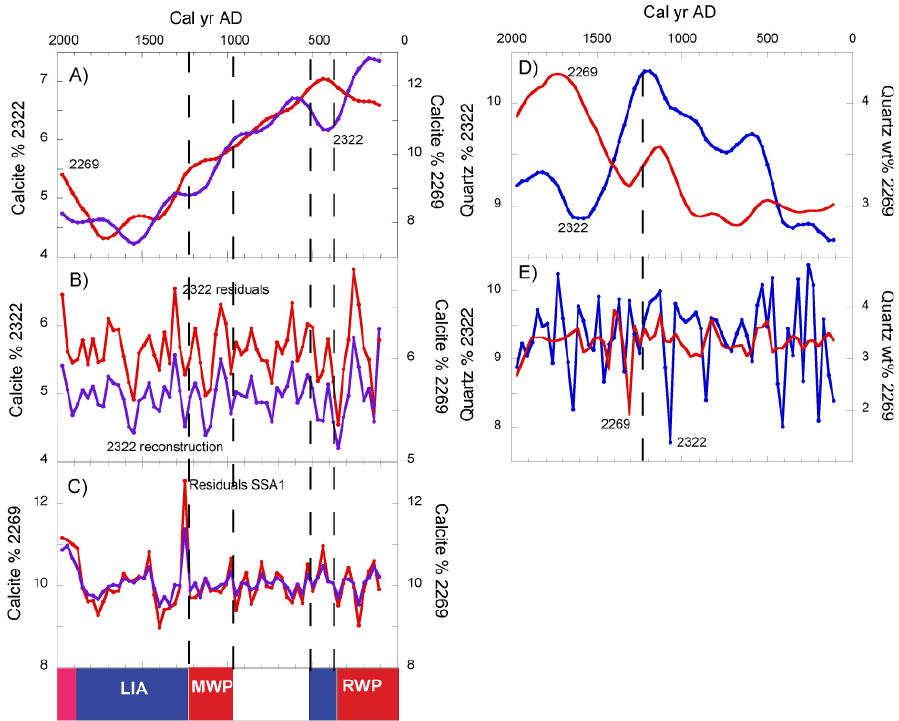
Fig. 11. (A) The SSA1 detrended calcite data for sites MD99-2322 and -2269 (Fig. 1), some 440km apart. (B) Residuals from the SSA1 trend for MD99-2322 (red) and the reconstructed time series (blue). (C) Residuals from the SSA1 trend for MD99-2269 (red) and the reconstructed time series (blue). (D) SSA trends on quartz wt%. (E) residuals from the quartz trends (Fig. 11e). The lower left panel shows the same climate intervals as in Fig.